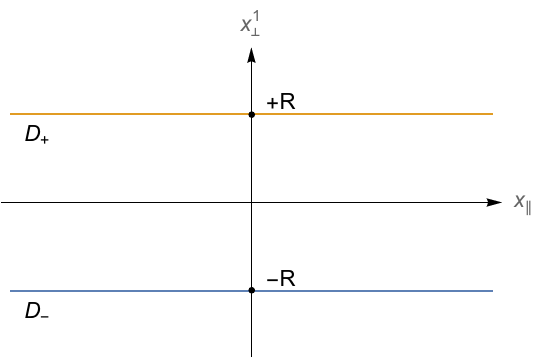
Figure 1 . The two line defects are separated by a distance of 2 R